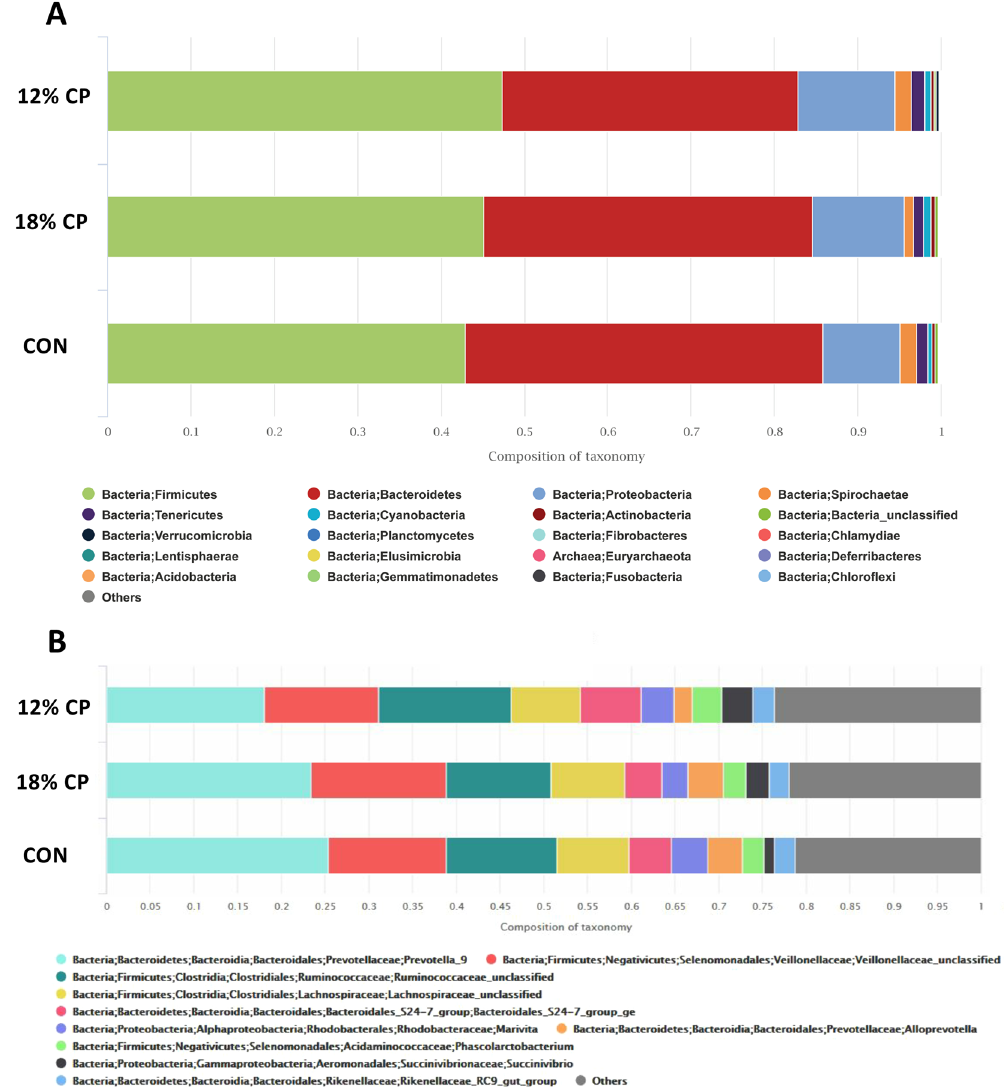
Figure 4. The effect of low protein diets on fecal bacterial community at phylum and genus level. ( A ) The relative abundance of bacterial community composition at phylum level in fecal samples of pigs fed with different levels of dietary protein. Only the top 20 phyla are depicted for clarity. ( B ) The relative abundance of bacterial community composition at genus level in fecal samples of pigs fed with different levels of dietary protein. Only the top 10 genera are depicted for clarity. CON, control diet with 24% crude protein (CP); 18% CP, low protein diet with 18% CP; 12% CP, low protein diet with 12% CP. n = 7, n = 7, n = 8 for CON, 18% CP and 12% CP groups,